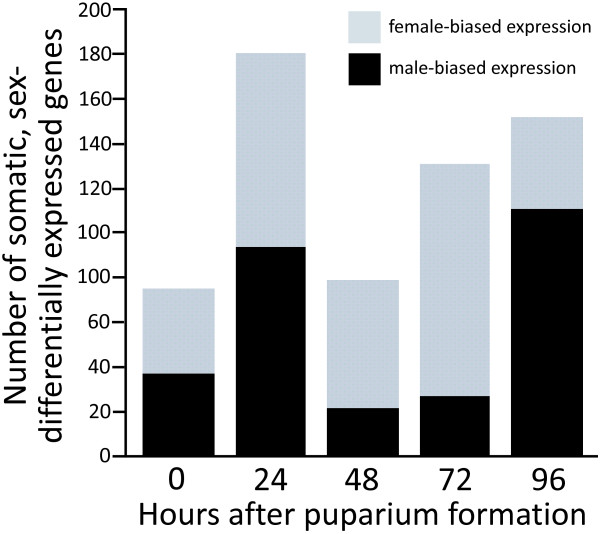
The number of genes with somatic sex-differential transcript levels differs across metamorphosis. The abscissa indicates the five time points during metamorphosis examined (0, 24, 48, 72, and 96 hour APF). The ordinate indicates the number of somatic, sex-differentially expressed genes, as identified by F-tests, q < 0.15, for sex or sex-time interaction terms, and a t-test of the means (q < 0.15), on the gene expression data of male and female tud progeny. Genes with female- and male-biased expression are shown in grey and black, respectively.